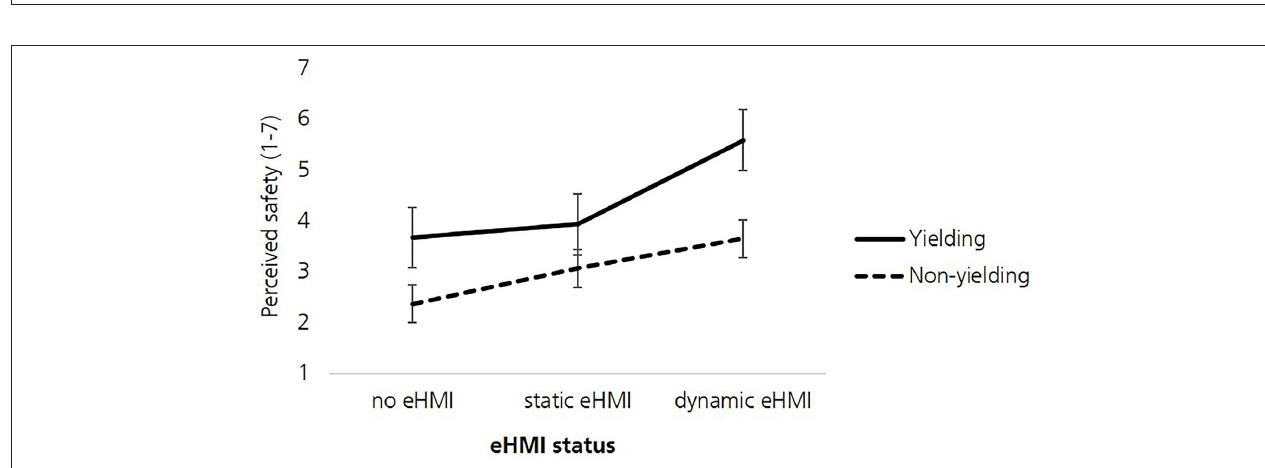
FIGURE 6 | Perceived safety regarding the eHMI status and vehicle kinematics. Error bars: ± 1 SE .